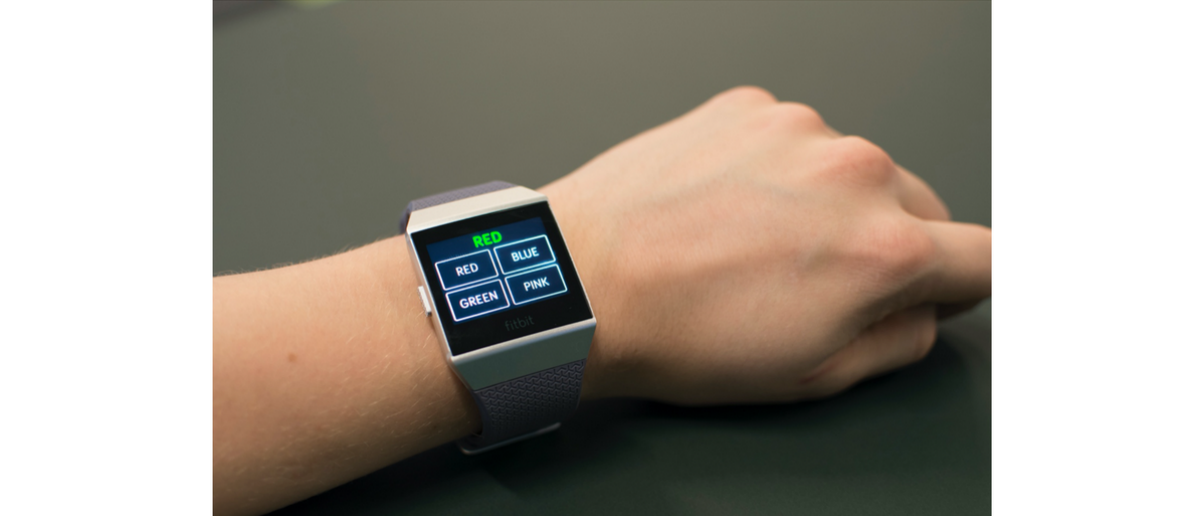
Figure 3. A sample test taken from the UbiCAT (Ubiquitous Cognitive Assessment Tool) Color test, displaying an incongruent stimuli.